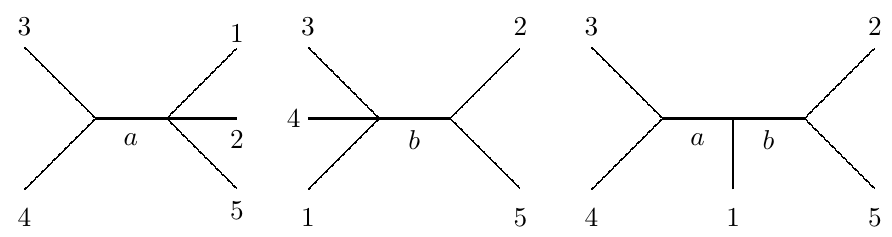
Figure 1 . Examples of Feynman diagrams and the labelling of their boundaries in our convention.